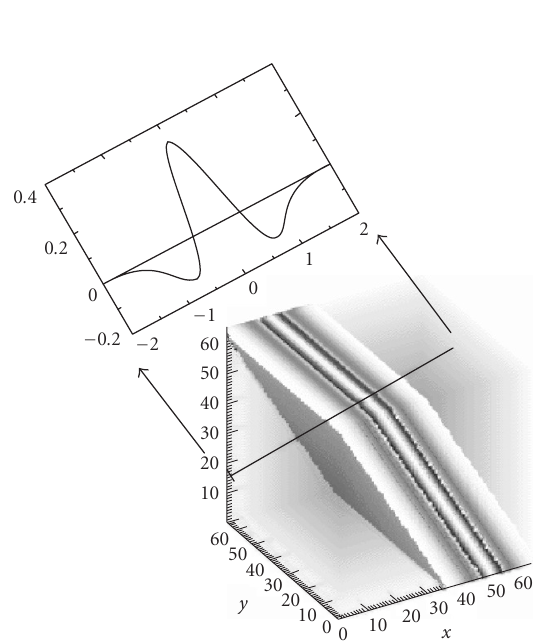
Figure 3: Example of 2D ridgelet function.